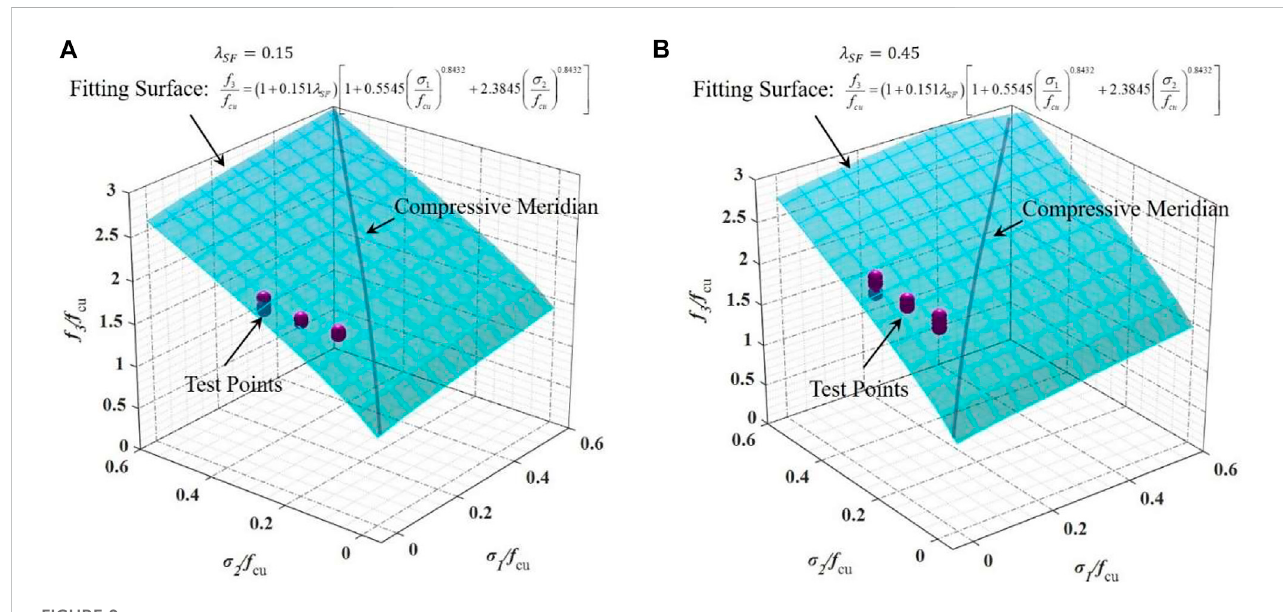
FIGURE 9 Fitting result diagram: (A) λ SF (cid:1) 0 . 15, and (B) λ SF (cid:1) 0 .